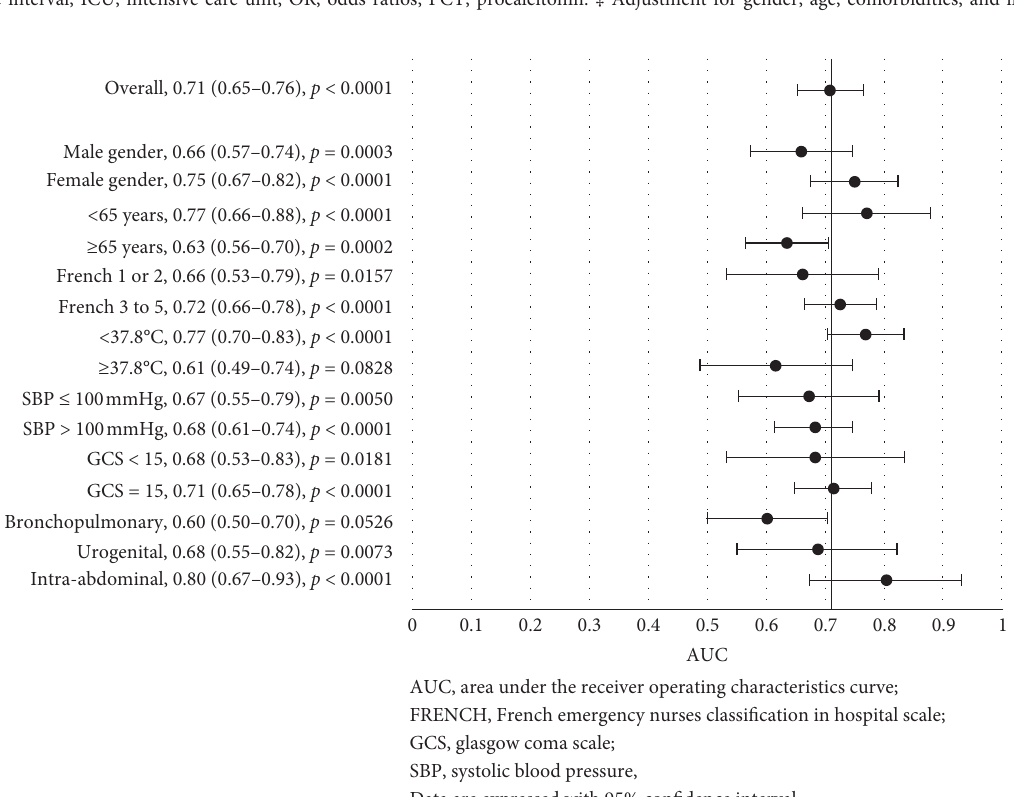
Figure 1: Forest plot of the area under the receiver operating characteristics curve for procalcitonin discrimination in in-hospital mortality, stratified by different